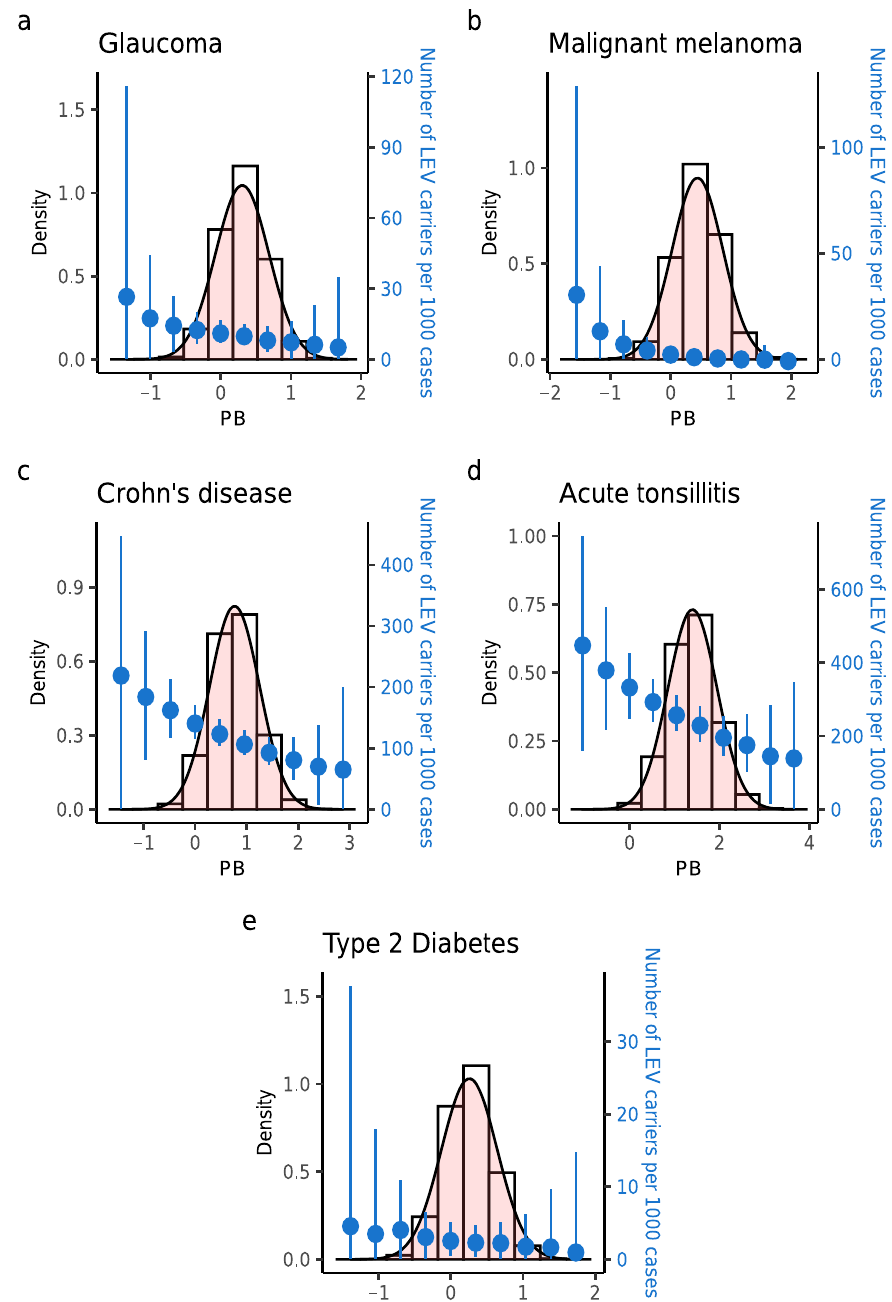
Fig. 7 Cases with low polygenic risk score have higher probability of carrying an LEV. Based on empirically-informed parameter values (i.e., derived from the UK Biobank), we performed simulations (under the liability-threshold model and the genetic architecture in line with negative selection) and compared the number of LEV carriers per 1000 cases among the different polygenic risk scores for a glaucoma, b malignant melanoma, c Crohn ’ s disease, d acute tonsillitis, and e type 2 diabetes. For each trait, we grouped the cases into ten equally-sized polygenic risk score bins. For each bin, the mean ± 1sd of the number of LEV carriers per 1000 cases is displayed as a blue circle and bar. The distribution of polygenic risk score is shown as a histogram. For example, per 1000 Crohn ’ s disease cases, 214 would be expected to be NOD2 frameshift mutation carriers from the lowest PB risk group; in contrast, PB-based LEV screening would be less effective for type 2 diabetes. The proportion of LEV carriers in the lowest PB risk group for acute tonsillitis was a nearly threefold increase relative to the highest PB risk group. Thus, the framework (assuming prespeci fi ed simulation parameters) provides testable predictions on the number of LEV carriers per 1000 cases with a given PB pro fi le and on the sample polygenic risk score pro fi le to optimize LEV screening. Detailed results can be found in Supplementary Data